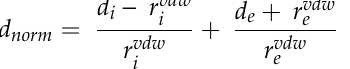
Figure 5. Cyclic Face-to-face stacking interaction between various rings in the crystal packing. Distances shown are in Å with H-atoms omitted for clarity.